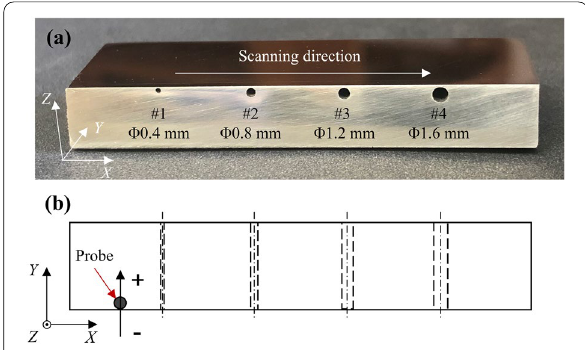
Figure 8 ( a ) The sample with four artificial defects, ( b ) the corresponding top view (The location of probe in the figure denotes the zero point in the Y